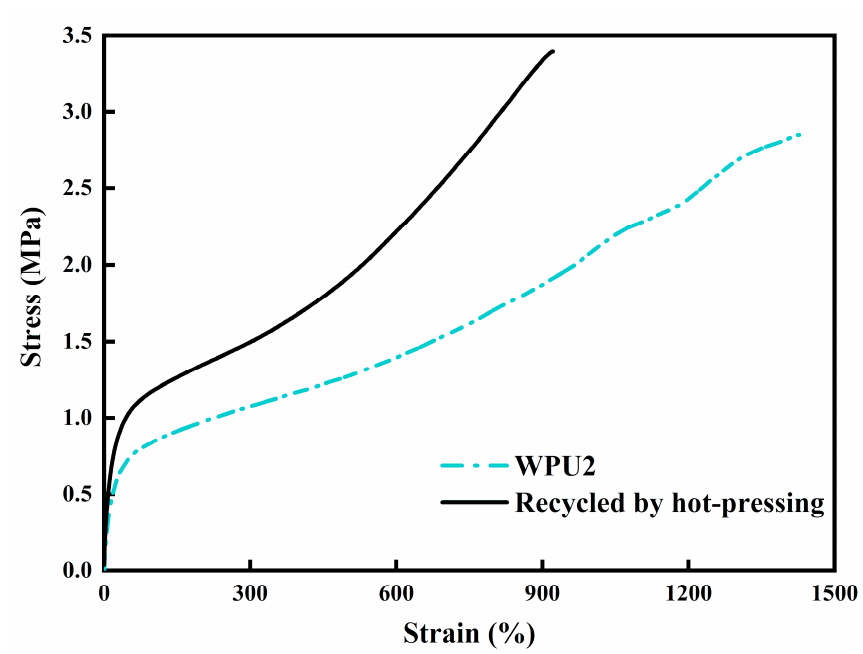
Figure 8. Tensile properties of the reprocessed WPU2 film.